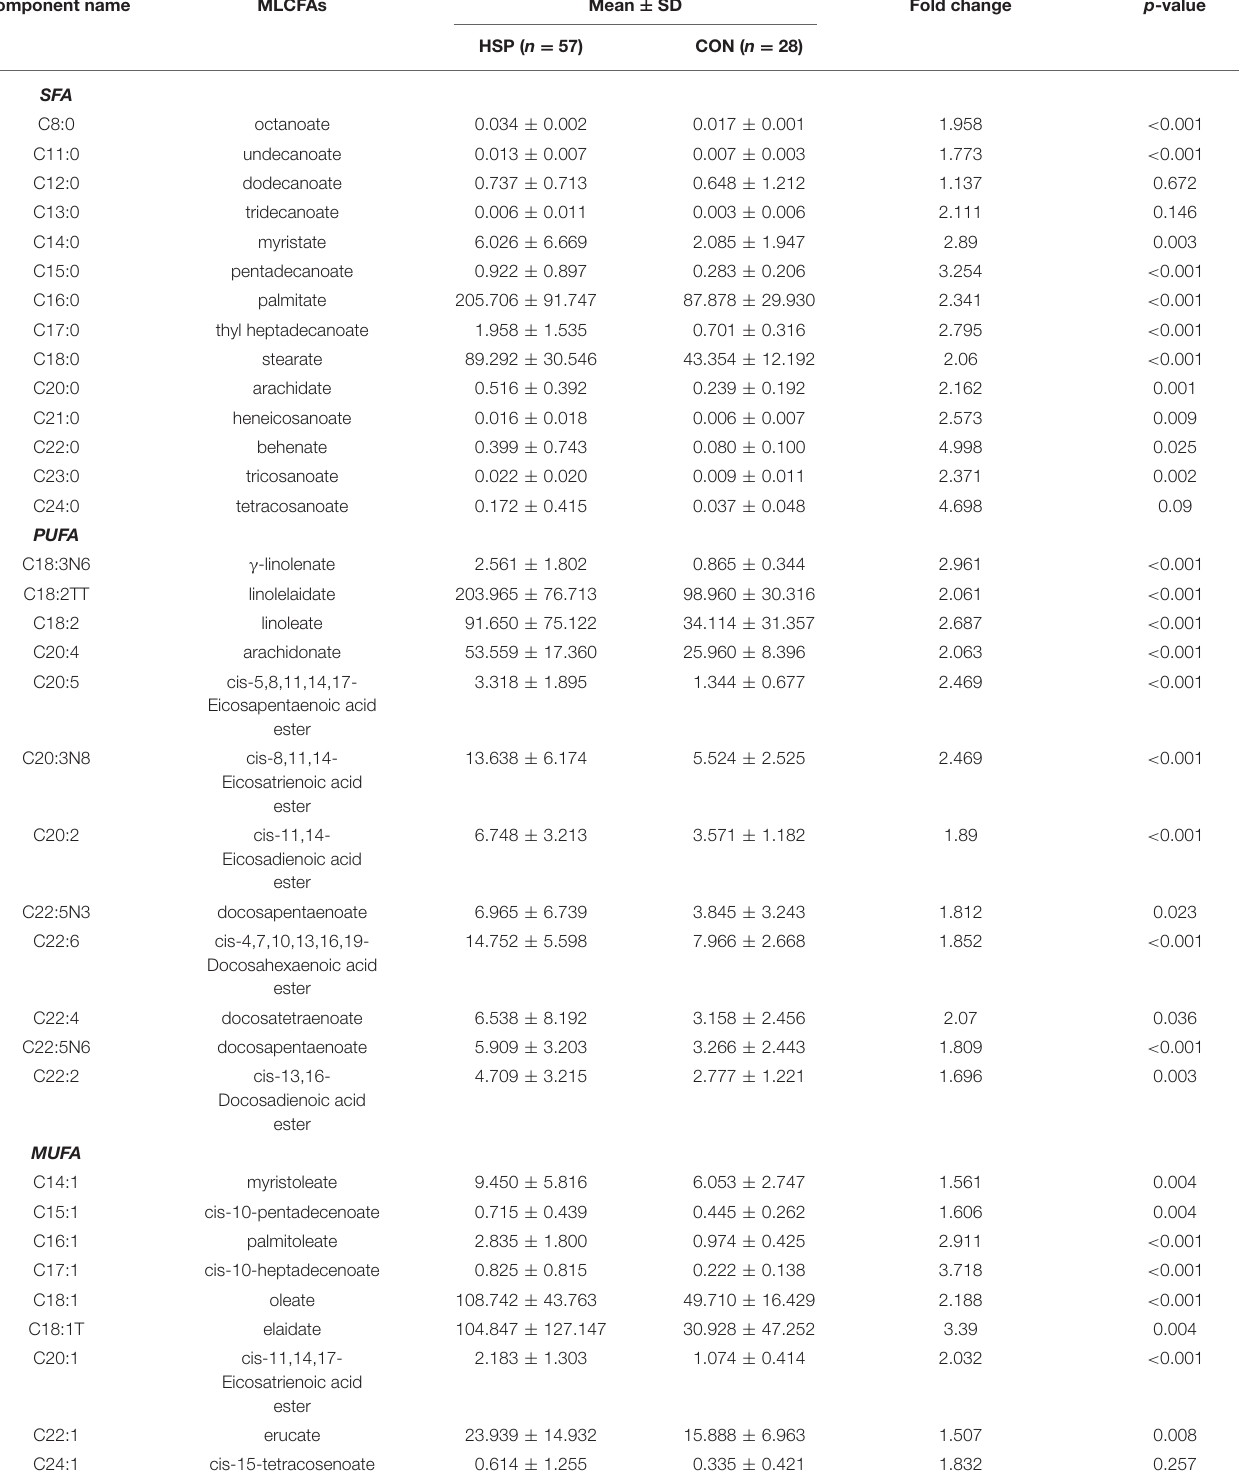
TABLE 2 | The percentage composition of 35 free fatty acids found in plasma from patients with HSP group and CON group. Component